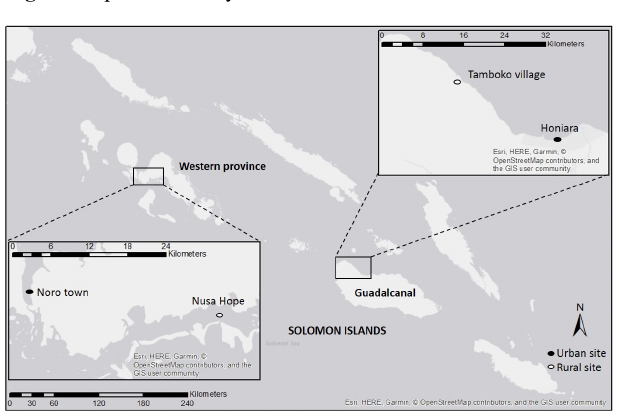
Fig. 1 . Map of the study